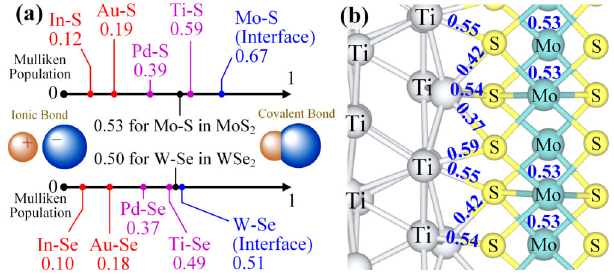
FIG. 16. (a) Maximum bond Mulliken populations (on a scale of 0 to 1) of top-contact interface bonds (colored numbers) compared to that of Mo-S (W-Se) bonds inside mTMDs (black numbers). (b) Bond Mulliken populations of the Ti-MoS 2 top contact. Population values are marked beside each interface bond. Population values of Mo-S bonds are also marked in MoS 2